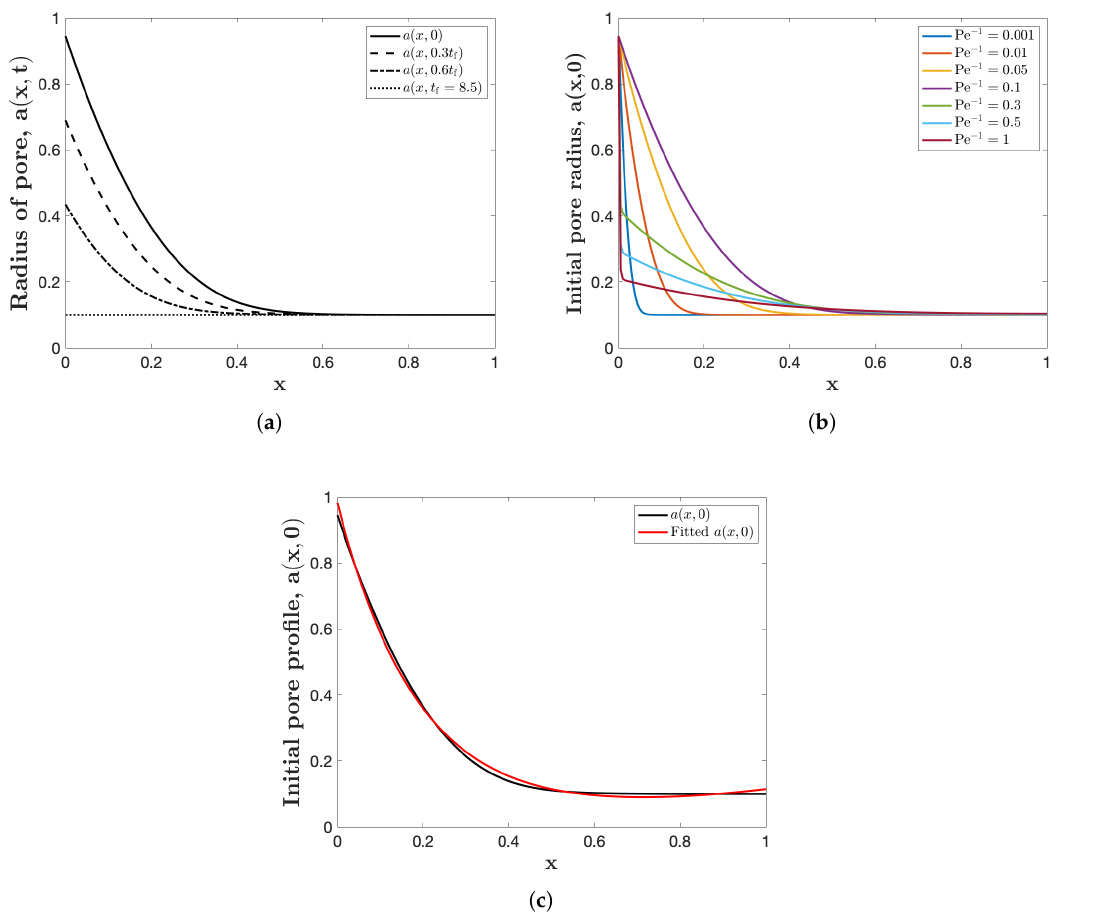
Figure 7. Reverse time filtration simulations: ( a ) pore radius a ( x , t ) at several different times with Pe = 10. ( b ) Initial pore radius for several different Pe − 1 . ( c ) The initial pore profile a ( x ,0 ) and the fitted exponential curve when Pe = 10. All figures are simulated with a ( x , t f ) = 0.1, λ = 2, β = 0.1, and ρ b =